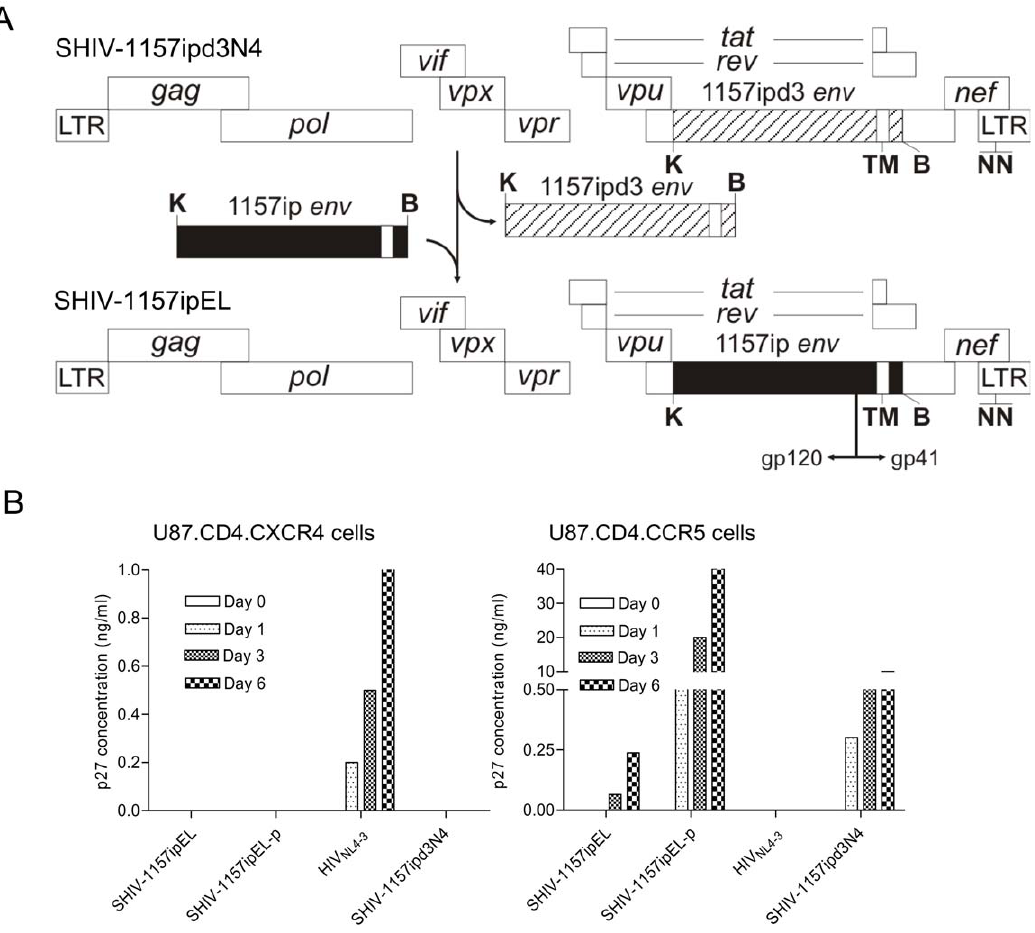
Figure 2. Construction and co-receptor usage of SHIV-1157ipEL. A. SHIV-1157ipd3N4 [1] was used as backbone to construct SHIV-1157ipEL. The 2.2 kb KpnI (K) - BamHI (B) fragment of the ‘‘early’’ SHIV-1157ip (spanning most of gp120, the entire gp41 extracellular domain, the transmembrane region (TM), and part of the cytoplasmic domain) (closed black bar) was used to replace the corresponding region of the proviral backbone (stippled bar). The modified 3 9 -half of was ligated with the 5 9 half of SHIV-1157ipd3N4 DNA to form full-length SHIV-1157ipEL. NN: 2 NF- k B sites present in the 3 9 LTR. During viral replication, this duplication of NF- k B sites copied into the 5 9 LTR. B. Coreceptor usage of SHIV-1157ipEL and SHIV-1157ipEL-p. U87.CD4.CCR5 and U87.CD4.CXCR4 cells were exposed to parental SHIV-1157ipEL, passaged SHIV-1157ipEL-p, SHIV-1157ipd3N4 (clade C, R5 SHIV), and HIV NL4-3 (HIV clade B env, X4). The levels of p27 Gag were measured in the supernatants as indicated.